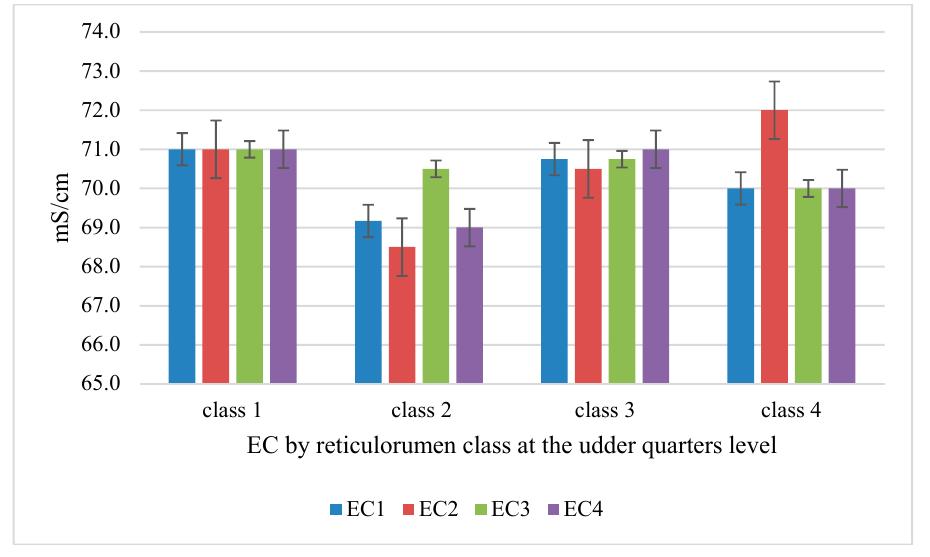
Figure 3. Comparison of electrical conductivity of milk (EC) (mS/cm) by udder quarter level according to reticulorumen pH classes. EC1—front left, EC2—front right, EC3—rear left, EC4—rear right. mS/cm—milisiemens per centimetre.